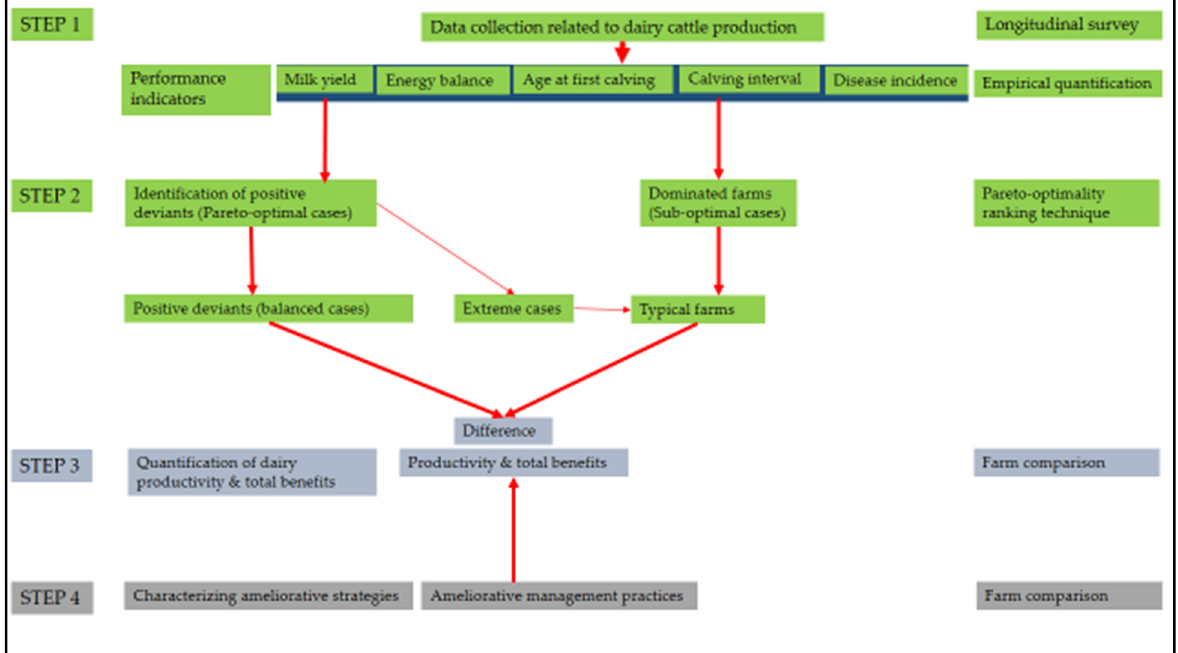
Figure 2. The methodological framework used to identify positive deviant farms and effective ameliorative management practices in smallholder dairy cattle farming systems under stressful production environments.